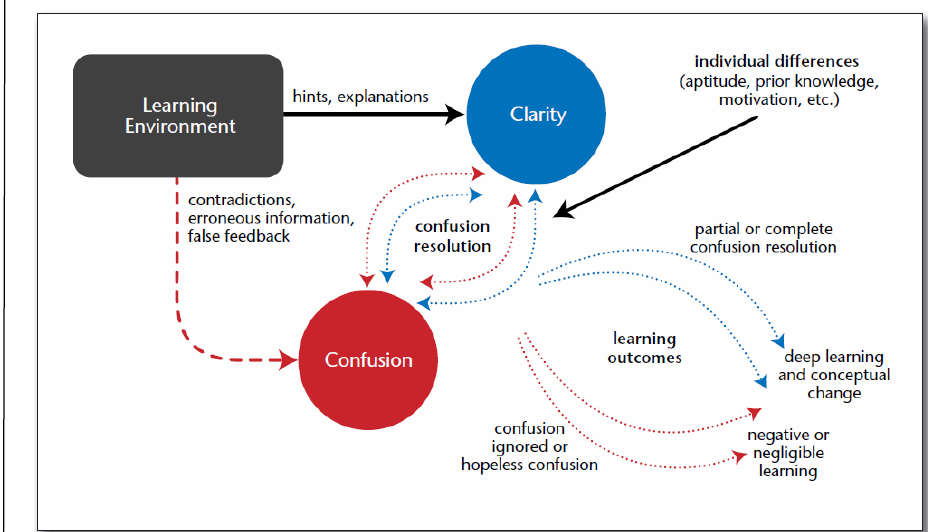
Figure 2 – Model of Confusion, Prejudice and Misunderstanding Induction and Resolution (Rus et al, 2013, pp.42-54) Рис . 2 – Модель несоответствий , неточностей , сомнений , неясности , объяснений (Rus et al, 2013,